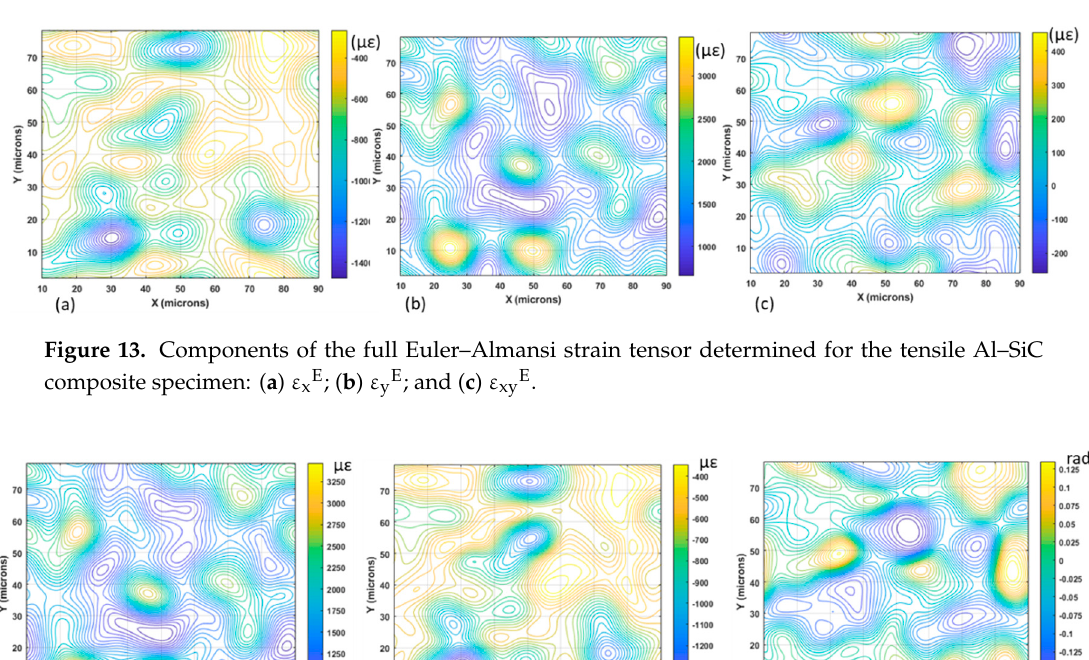
Figure 13. Components of the full Euler–Almansi strain tensor determined for the tensile Al–SiC composite specimen: ( a ) ε xE ; ( b ) ε yE ; and ( c ) ε xyE .